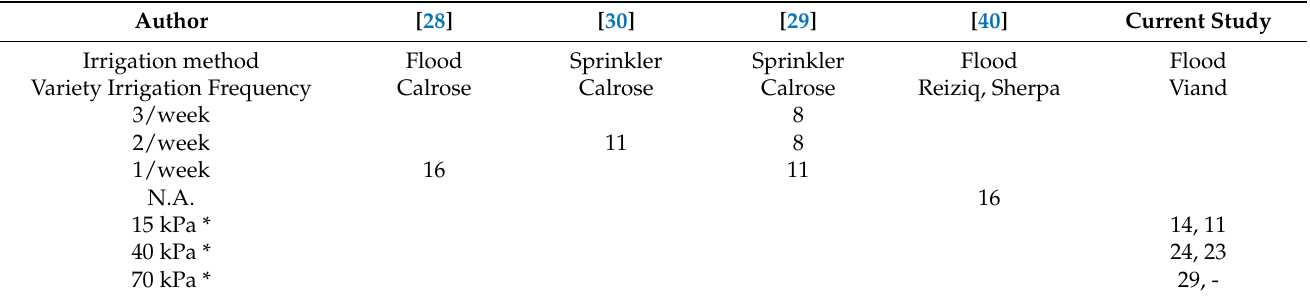
Table 6. Number of days anthesis was delayed relative to traditional flooded controls in previous Australian water-saving rice research. * in the current study, the delay of the 15 kPa versus flooded rice is estimated, with the extra delay in the 40 & 70 kPa treatments added to the estimate with the value of Year 1 listed before Year